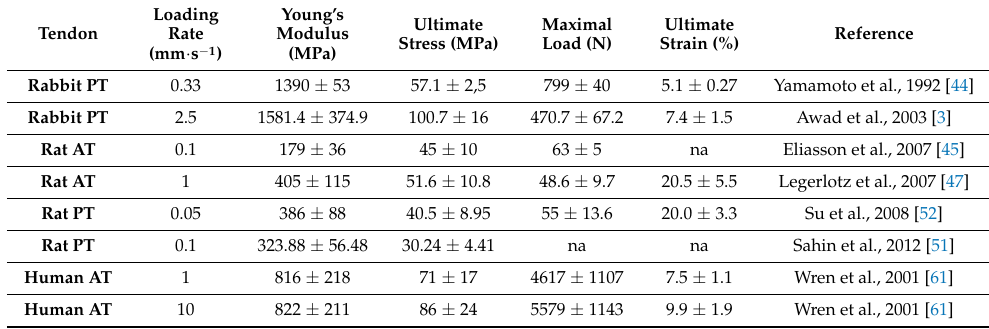
Table 4. Influence of strain rate on mechanical properties (mm/s). ‘na’ indicates unavailable data.